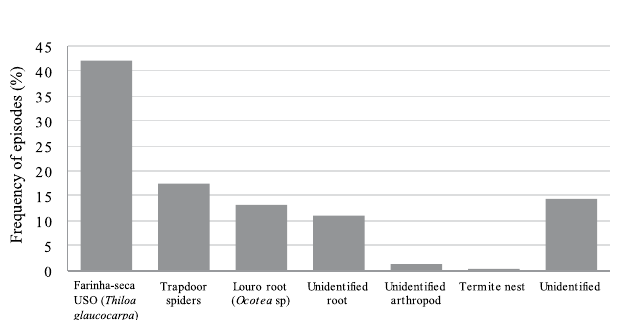
Figure 2. Food items searched by the monkeys with the aid of DSTs. Unidentified resources correspond to episodes in which we were unable to determine the target resource even after site